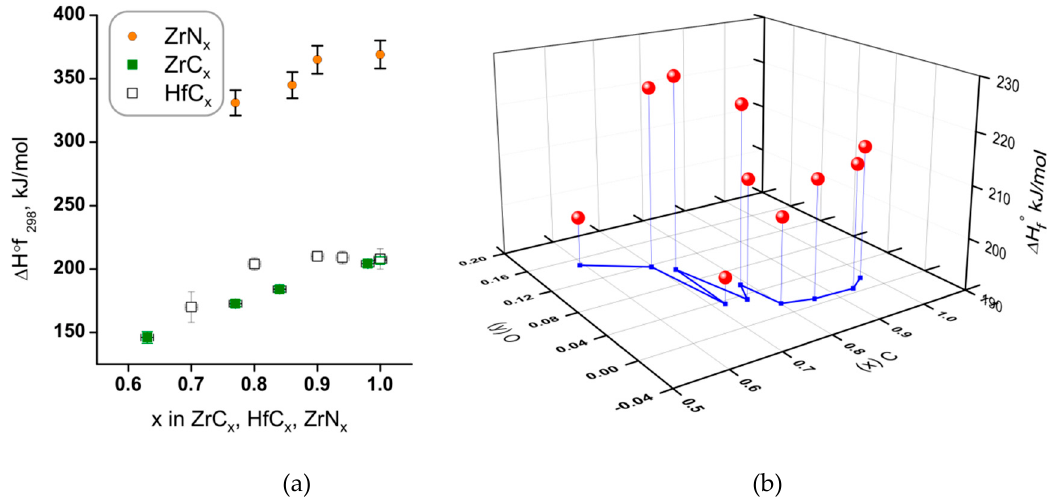
Figure 6. ( a ) Standard enthalpies of formation of Zr and Hf carbides and Zr nitrides as a function of carbon content. ( b ) Standard enthalpies of formation of 10 hafnium oxycarbides HfC x O y plotted measured by Kornilov et al. [125], from which the values for HfC x were derived. Note that the oxygen content reaches y = 0.15 for most carbon deficient composition. See Tables S3 and S4 for reported uncertainties.